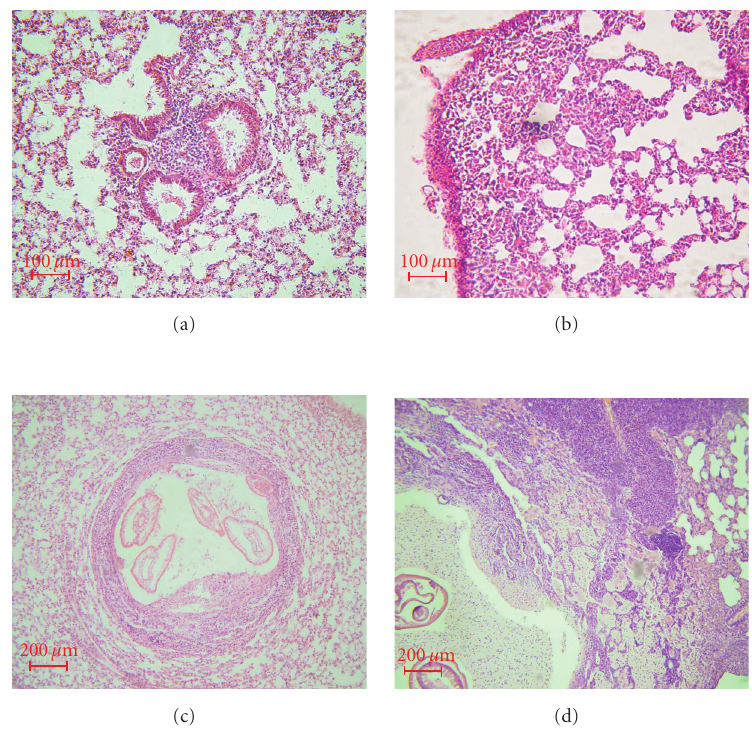
Figure 2: Lungs of mice infected with Lagochilascaris minor . Lungs of (a) an A/J mouse with perivascular and peribronchial mild inflammatory infiltration of macrophages and a few neutrophils (H&E, scale = 100 μ m) and (b) a B10.A mouse (b) with severe and di ff use inflammatory infiltration composed of macrophages, neutrophils and few eosinophils (H&E, scale = 100 μ m), both collected 30 days after infection. Lungs of (c) A/J mouse with varying degrees of damage, including secondary granuloma containing larvae in di ff erent degrees of destruction, concentric fibrosis and foci of inflammatory infiltration composed of macrophages (H&E, scale = 200 μ m) and (d) B10.A mouse with secondary granuloma and severe and di ff use inflammatory infiltration in the lungs with a predominance of macrophages and few neutrophils (H&E, scale = 200 μ m), both collected 60 days after infection.